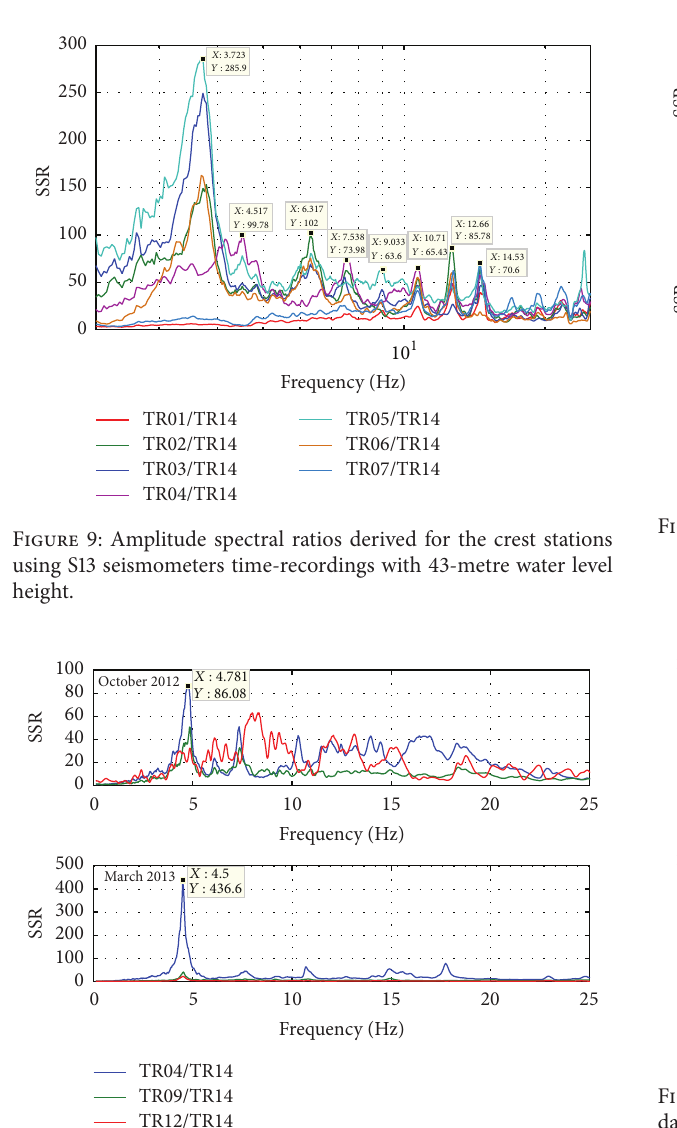
Figure 12: Radial spectral ratios derived for the right side of the